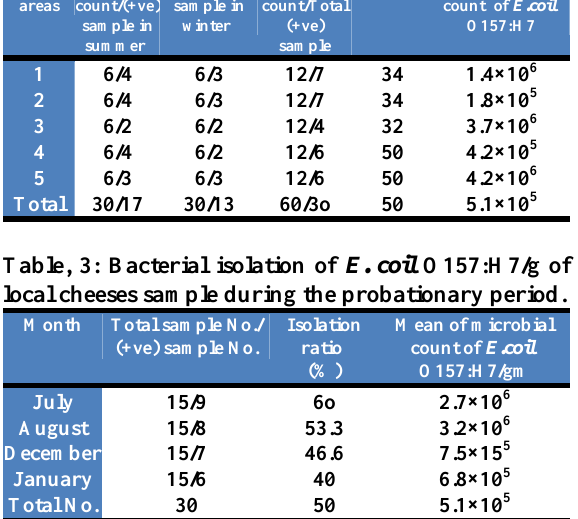
Mean of microbial count of E.coil O157:H7